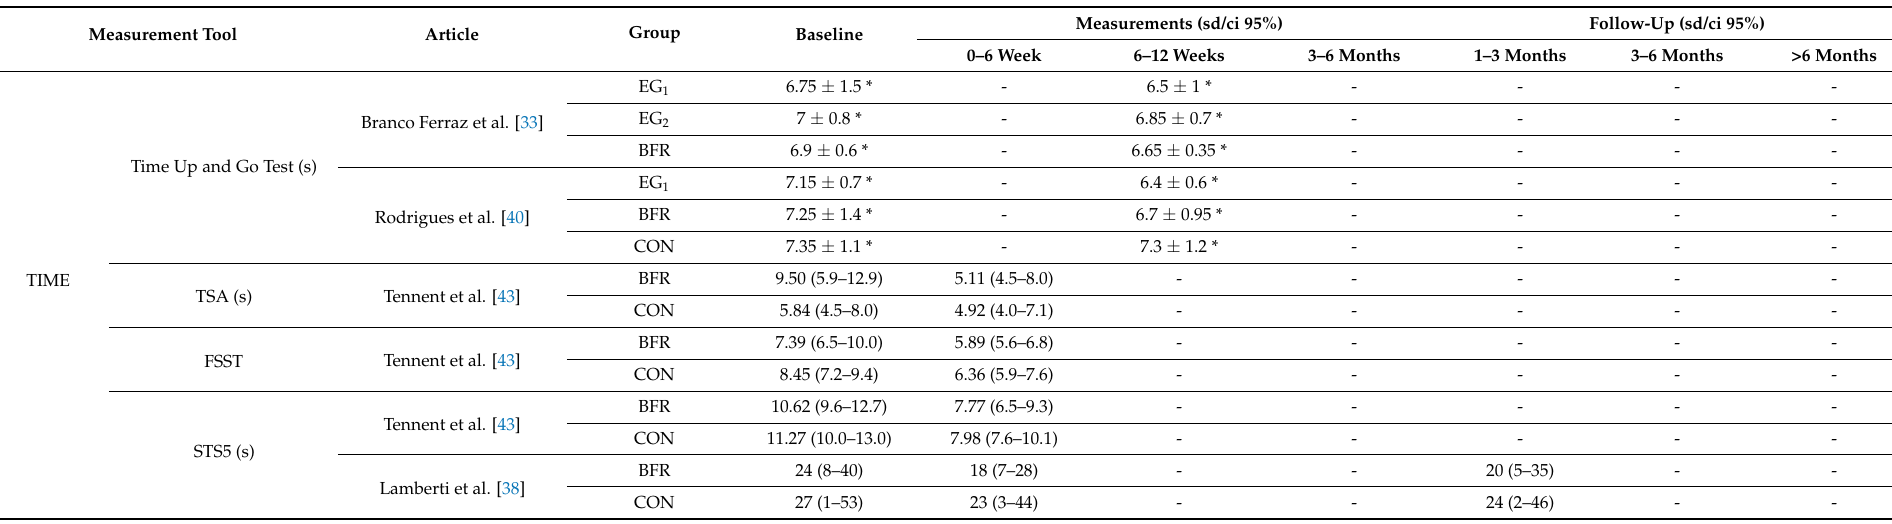
Table 3. Results of the functionality variable (objective outcomes), analyzed in the short-, medium- and long-term, both during the intervention period and in a follow-up that could be longer than 6 months after the end of the